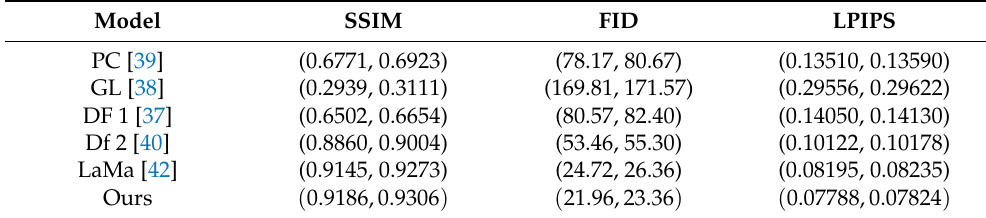
Table 3. The lower (left) and upper (right) limits of confidence are 95% of quantitative comparison of the proposed method with an already publicly available, robust baselines in FID, LPIPS, and SSIM metrics. The results of each model were derived from its public code.